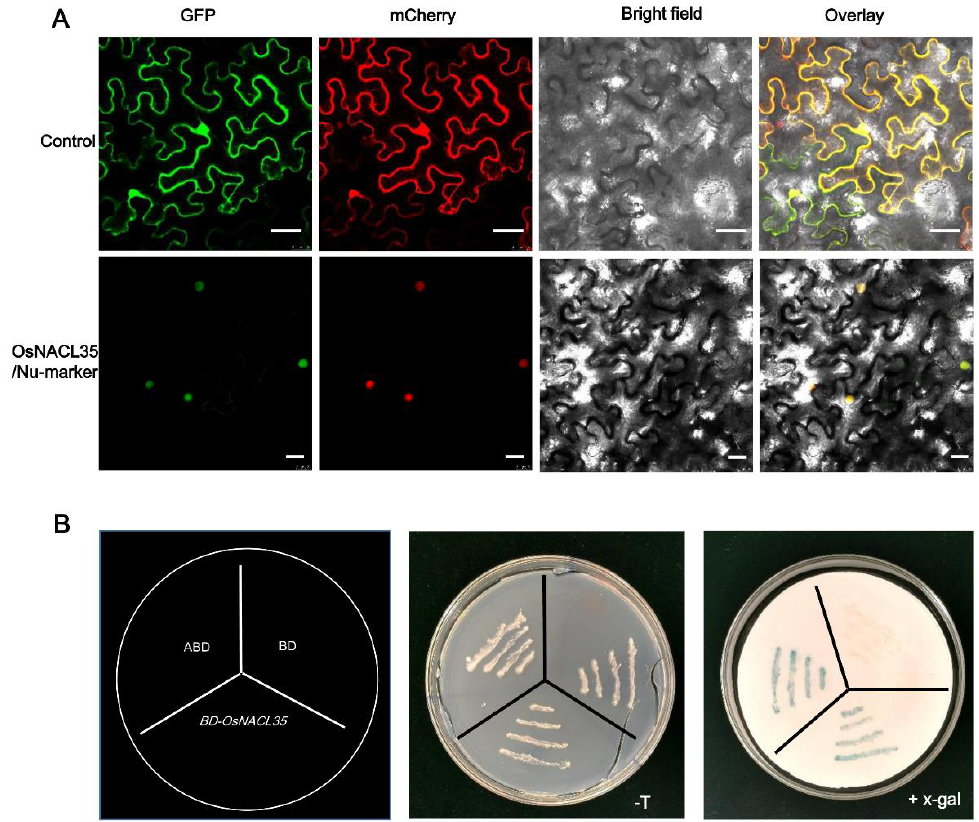
Figure 2. Subcellular localization and transactivation analysis of OsNACL35. ( A ) OsNACL35 is localized in nucleus. 35S:GFP, 35S:OsNACL35-GFP, and nuclear marker (BES1n-mCherry) were expressed in the leaves of Nicotiana benthamiana . Leaves were collected at 48 h after infiltration for observation under a confocal laser scanning microscope (Bar = 50 µ m). ( B ) Transactivation assay of OsNACL35 in the yeast strain AH109. Recombinant constructs of pGBKT7–OsNACL35 were expressed in the yeast strain AH109. The vector pGBKT7 was expressed in yeast as a control, and ABD as a positive control. The plates were incubated for 3 days and then subjected to the galactosidase assay.